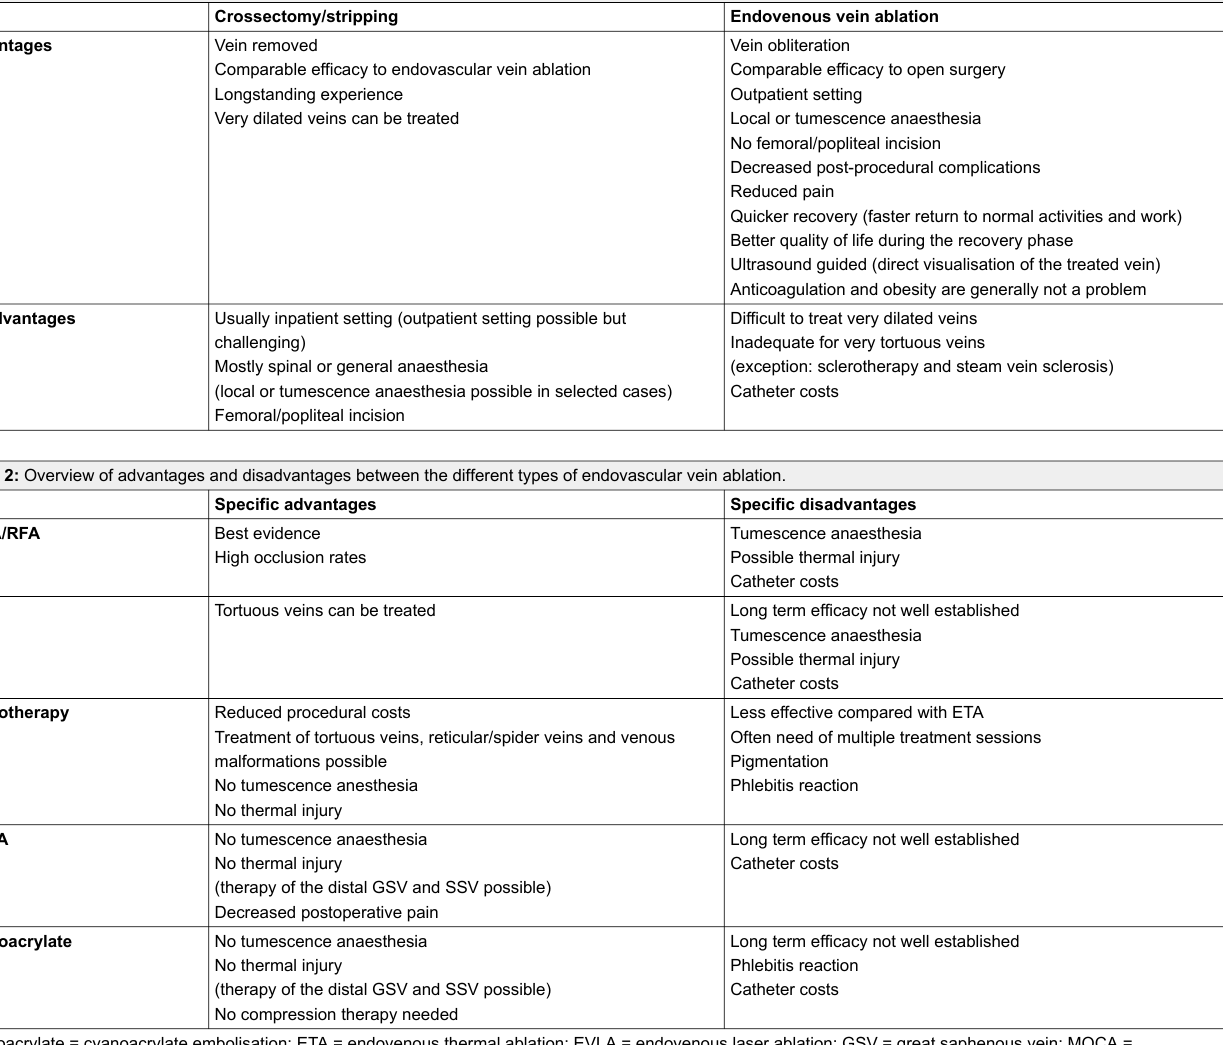
Table 1: Overview of the differences between crossectomy/stripping and the endovascular vein ablation procedures. Note that some advantages and disadvantages are the authors’ opinions with lack of clear evidence. Crossectomy/stripping